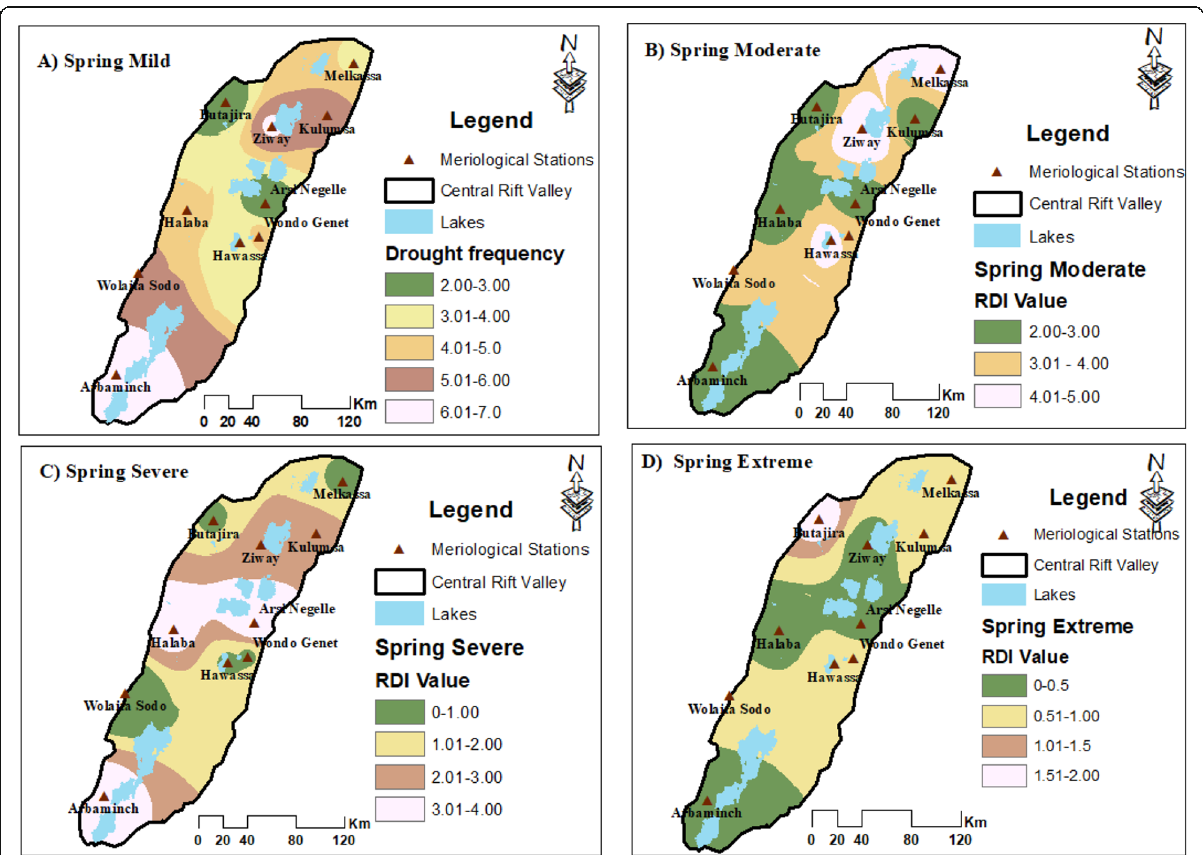
Fig. 7 Spatial distribution of drought frequency in spring season in LRERV of Ethiopia: a mild drought, b moderate drought, c severe drought, d extreme